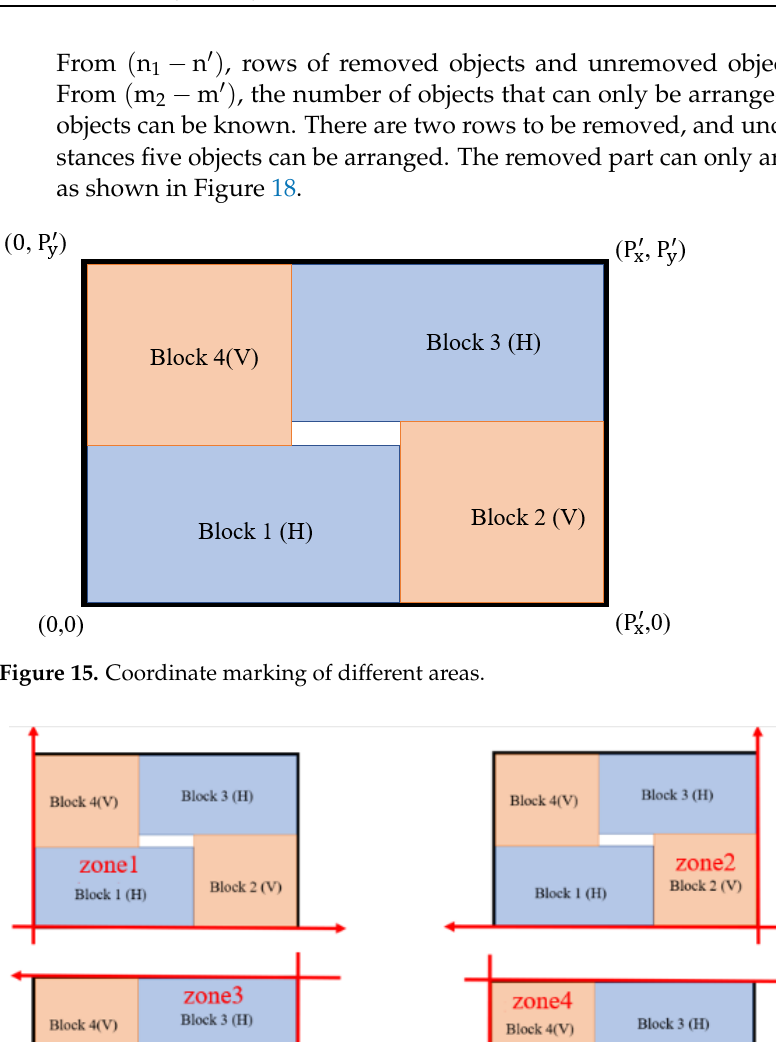
Figure 16. Each area in a different quadrant.